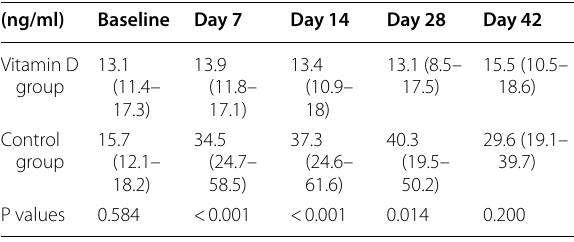
Table 1 Vitamin D level at each time